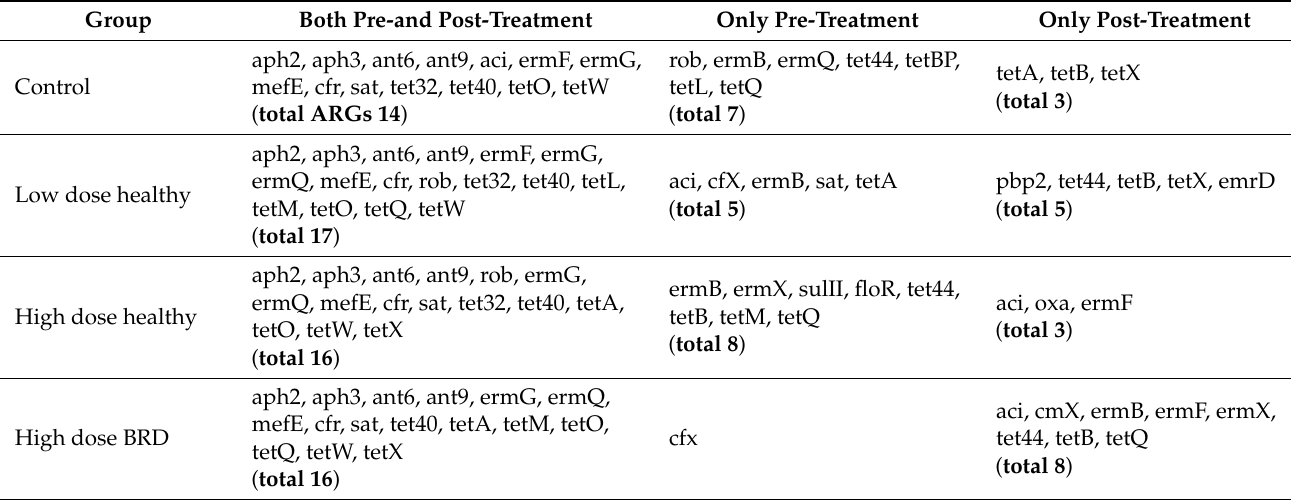
Table 8. Variations of ARGs between pre- and post-treatment pooled fecal samples in four groups of calves. The control group did not receive any